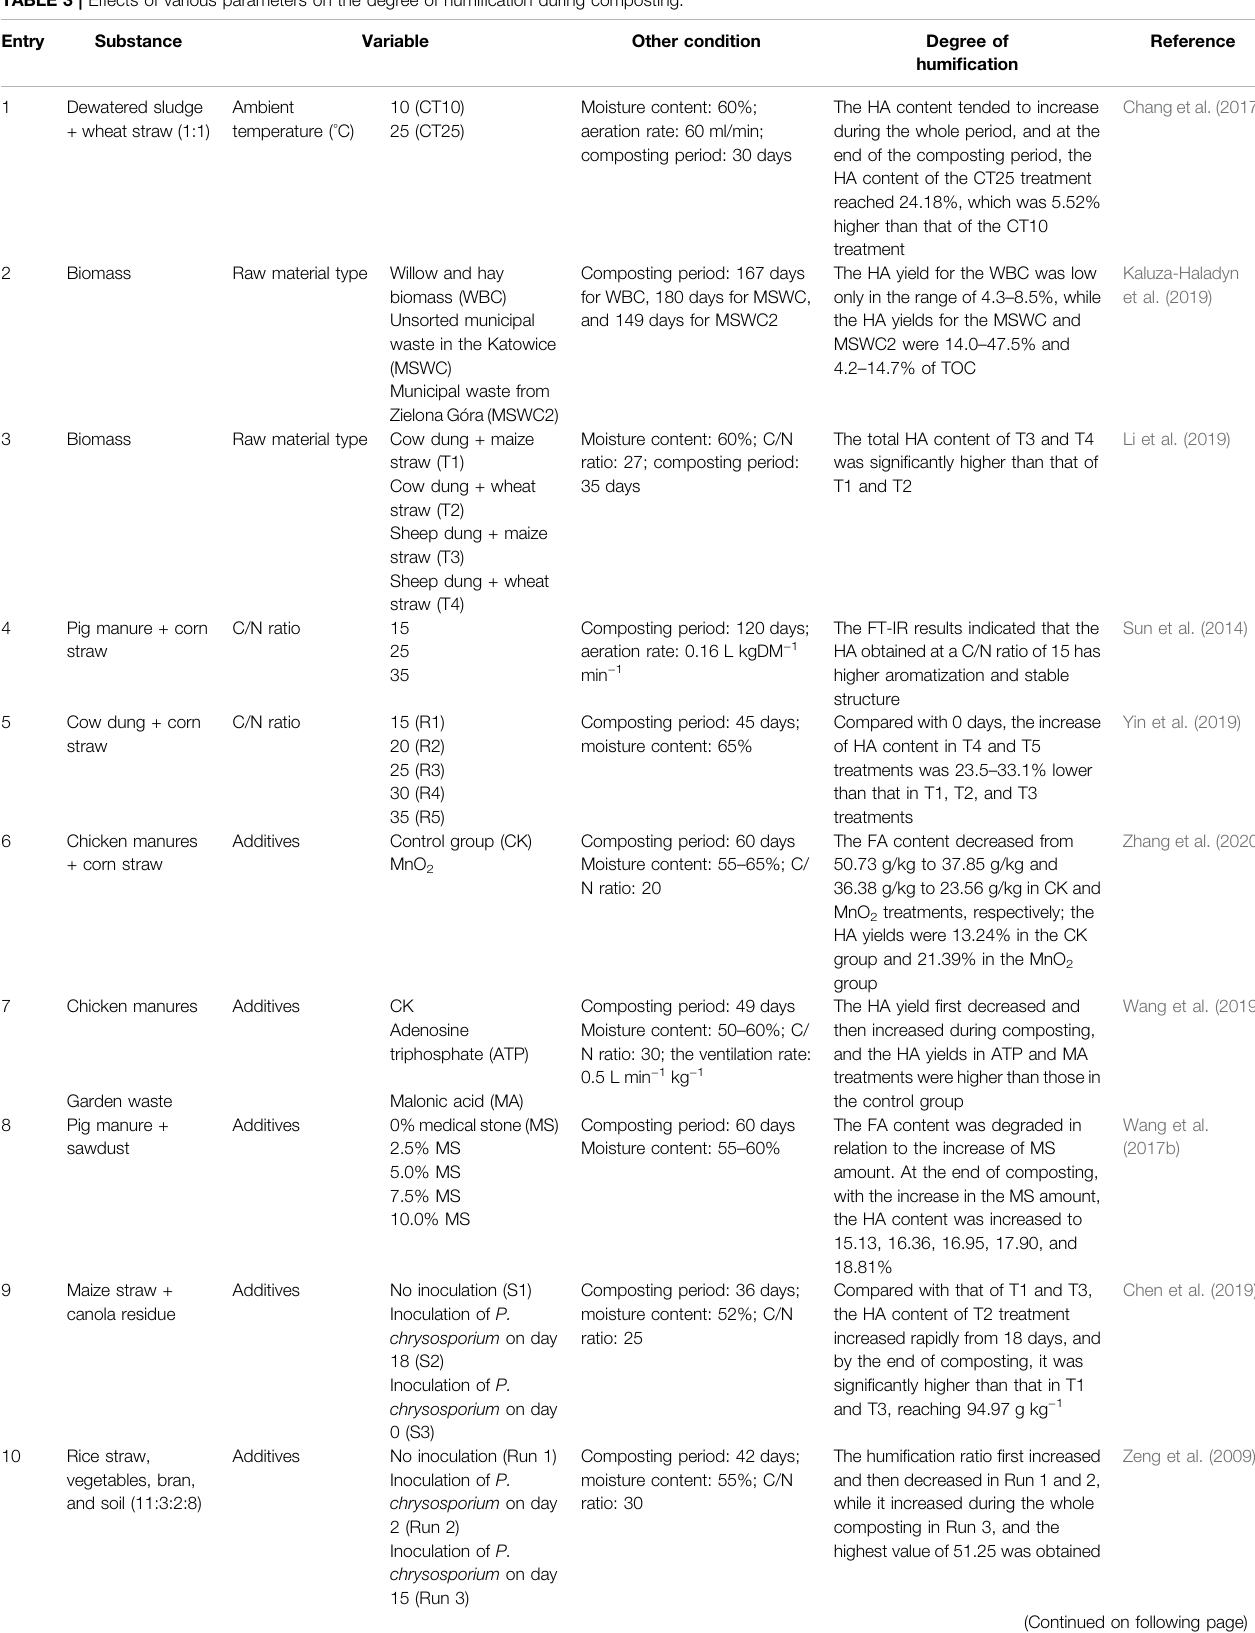
TABLE 3 | Effects of various parameters on the degree of humi fi cation during